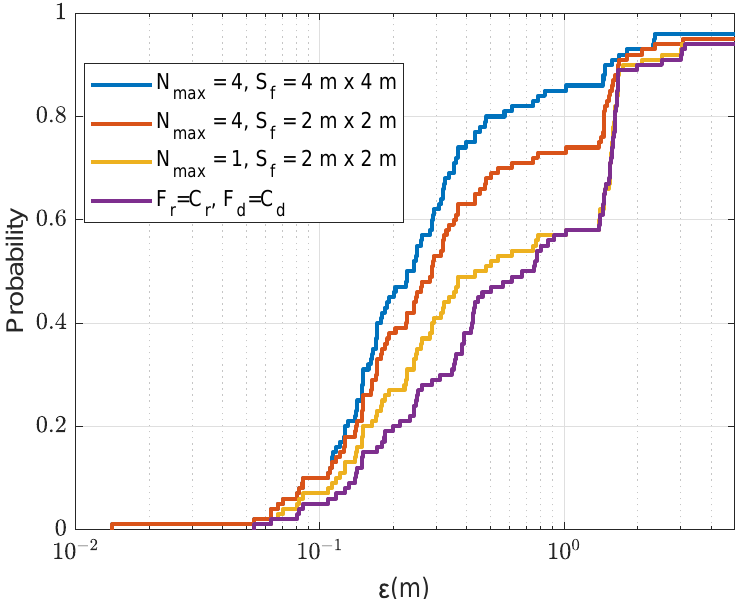
Figure 15. CDF for the localization error ε in the acoustic environment with the SWellEx-96 SSP against the size of the refinement area S f and number of refinement areas N max , where one points are removed after finding the next coarse AF maximum; N T = 1; F r = F d = 0.5